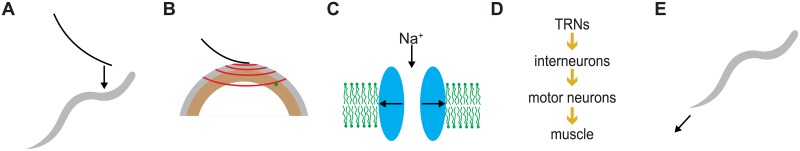
The C. elegans touch response encompasses the entire mechanotransduction pathway from mechanical stimulus to behavior.(A) In the classical touch assay, a stimulus is applied with an eyebrow hair, (B) force is transmitted through the worm, (C) ion channels regulate depolarization of a touch neuron, (D) interneurons pass the signal between the touch neuron and motor neurons, and (E) motor neurons activate body wall muscles to produce a behavioral response.